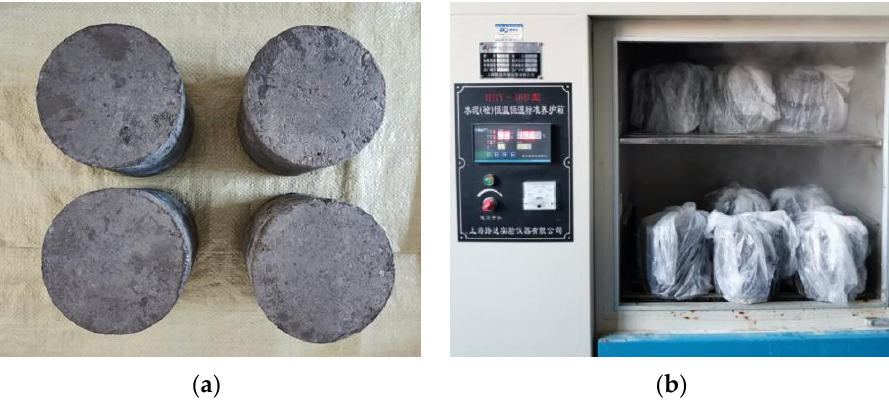
Figure 4. ( a ) Prepared specimens and ( b ) curing of specimens.